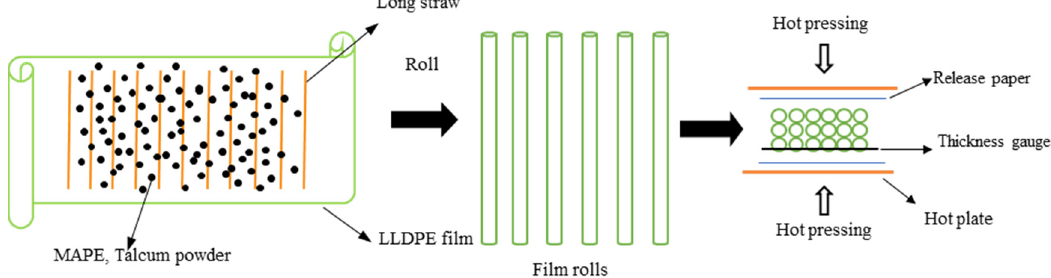
Figure 1. Preparation of straw / LLDPE composite through the film-roll hot pressing process.